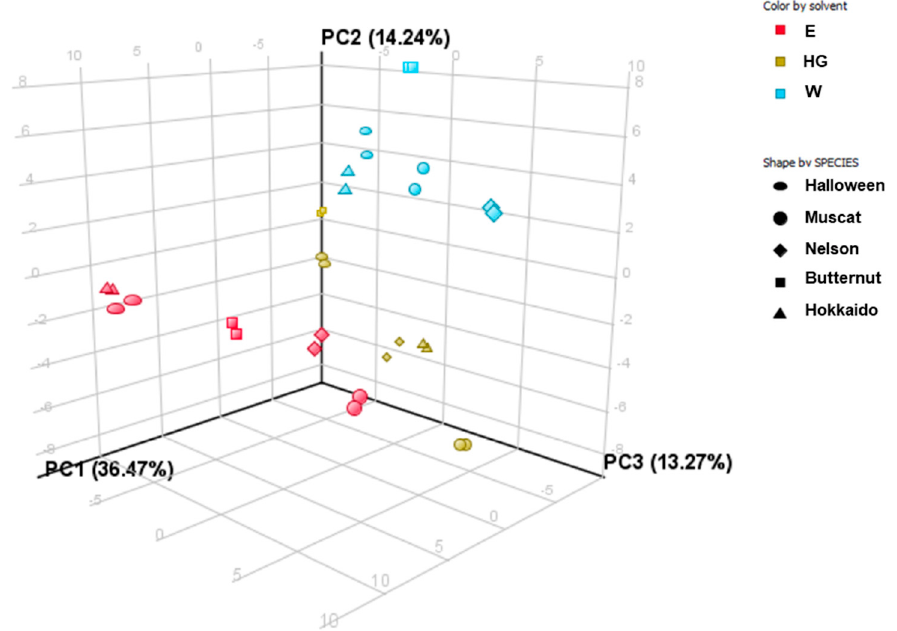
Figure 3. Scores of the first three principal components of the PCA explaining 63.98% of the variability in the obtained dataset. Explanation of the abbreviations: aqueous extracts (W), hydroglycolic extracts (HG), hydroethanolic extracts (E).